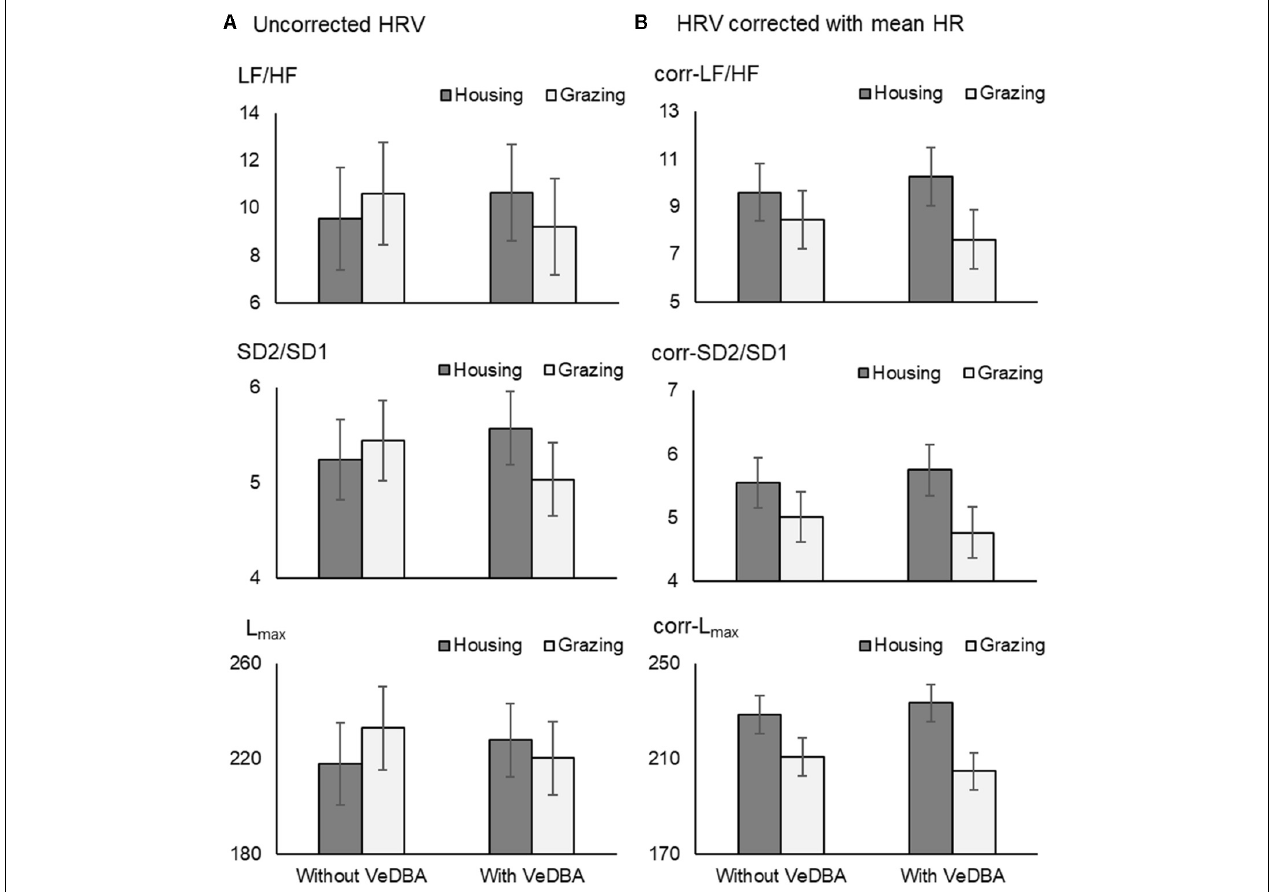
FIGURE 4 | The effects of VeDBA on uncorrected HRV parameters (A) and HRV parameters corrected for mean HR (B) in cattle. The corrected HRV parameters (corr-LF/HF, corr-SD2/SD1, and corr- L max ) were calculated by multiplying the uncorrected parameters by average inter-beat intervals (seconds) to the power of 2, 1, and 1, respectively. Y -axes in (A) are similar to those in (B) , because the average inter-beat intervals of cattle in the present study were approximately 1 s (1,000 ms). Hence, the data presented in (A) and (B) cannot be directly compared due to the differences in dimensions of the units. VeDBA, natural logarithmically transformed vectorial dynamic body acceleration ( g ); HR, heart rate; HRV, heart rate variability; LF/HF, the ratio of normalized power of the low frequency band to the high frequency band; SD2/SD1, the ratio of standard deviation of long-term HRV measured from axis 2 of Poincaré plot to axis 1 in Poincaré plot; and L max , the length of longest line of recurrent points